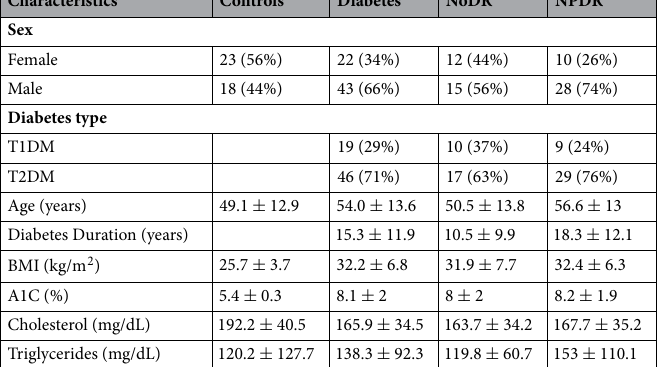
Table 1. Subject characteristics. Values are expressed as number (%) or mean ± SD Missing values were excluded to compute these